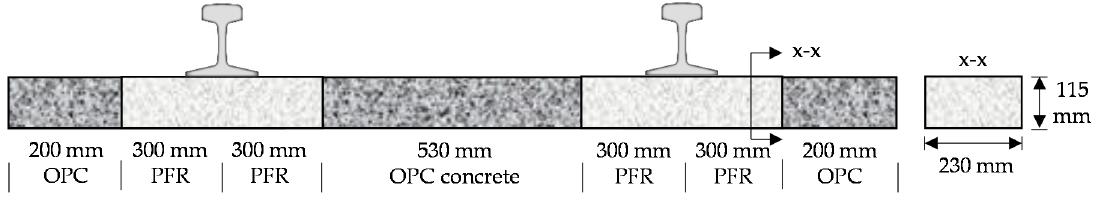
Figure 9. Full-scale deflection behaviour . ( a ) Five-point bending (5-PB) test setup. ( b ) Bending profile of sleeper.